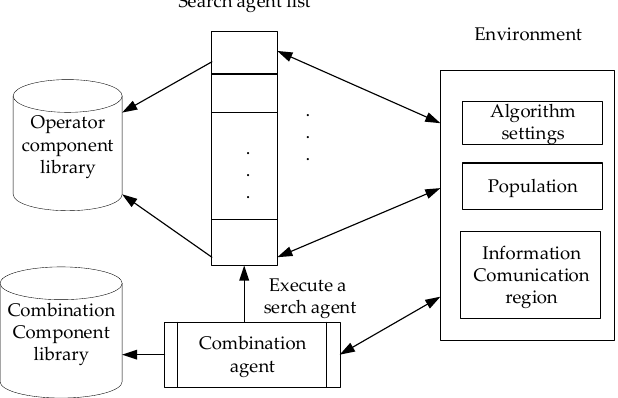
Figure 2. Agent-based framework structure.